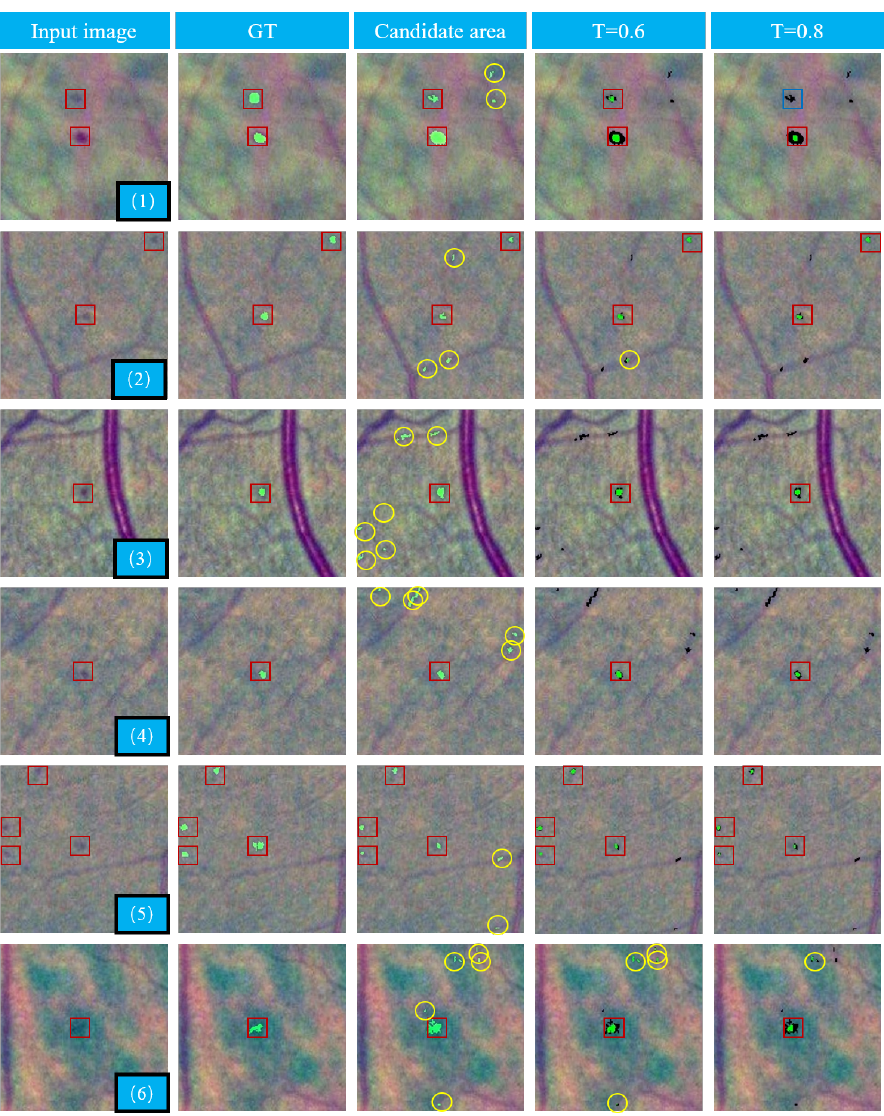
Figure 10. Illustration of pixel level validation. For better visualization, the correctly detected MAs and miss detection MAs are highlighted by red and blue squares, respectively. The FP candidates are highlighted by yellow